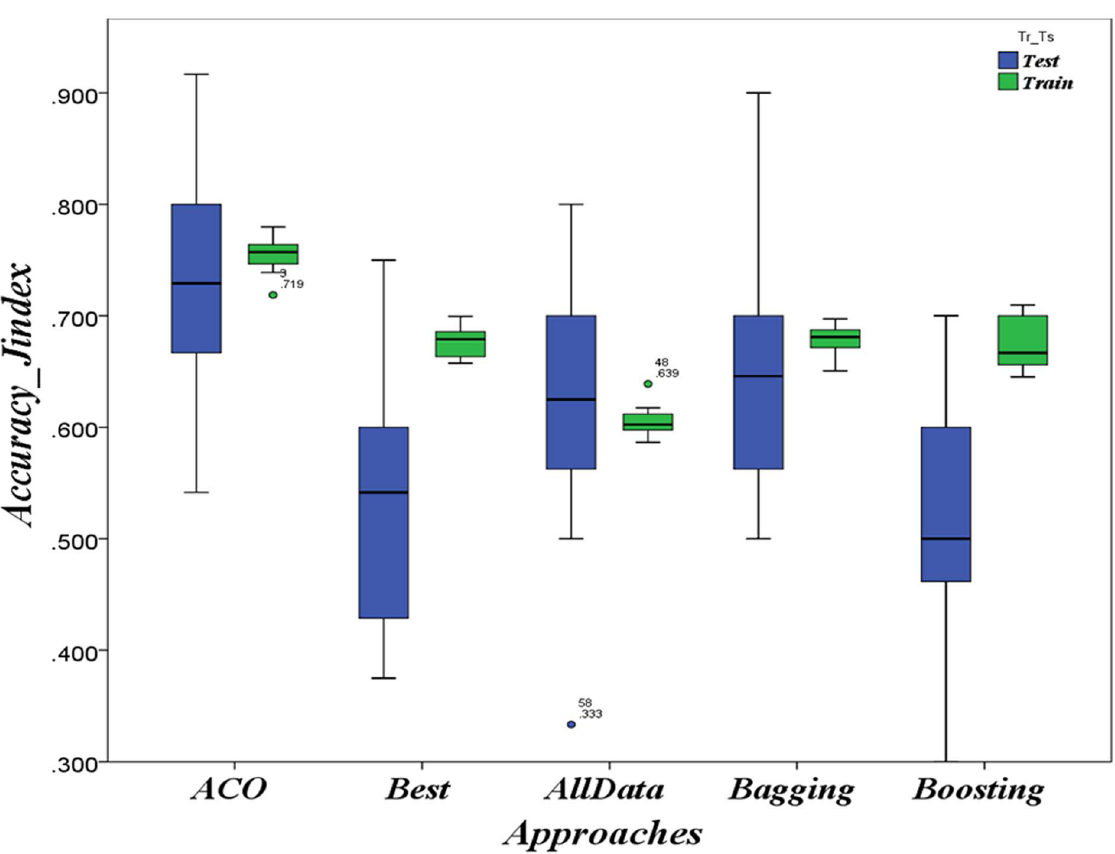
Figure 2. Evaluation in HD case: Prediction accuracies in the context of Cleveland population C Cleveland ACO-based approach Vs. Best model, data-combination Model, Boosting and Bagging.